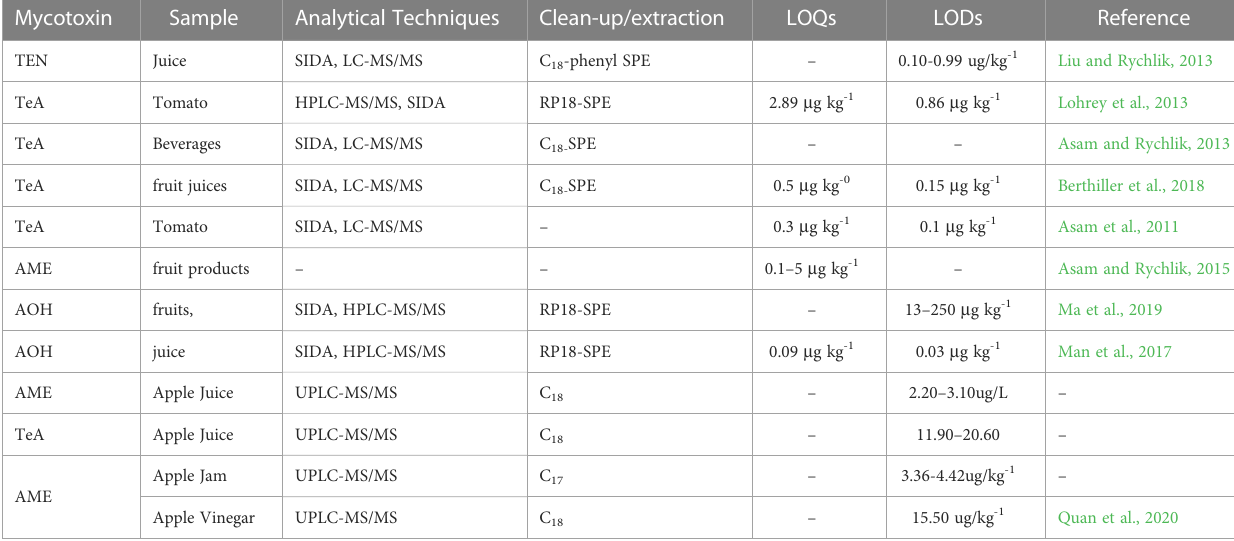
TABLE 6 Alternaria mycotoxin detection using LC-MS and